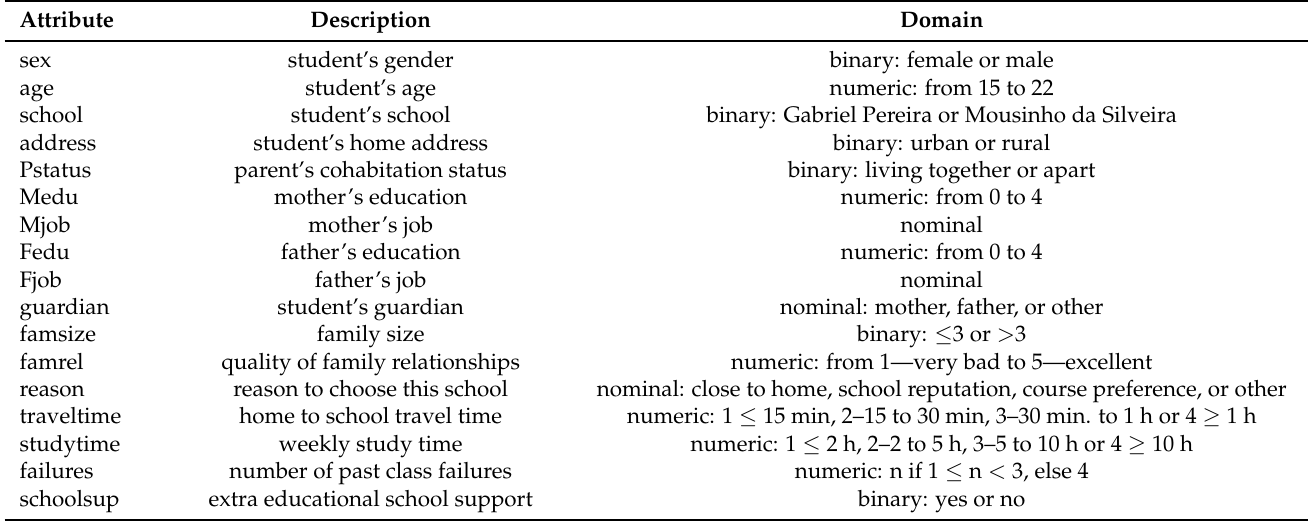
Table 1. Attributes of students from